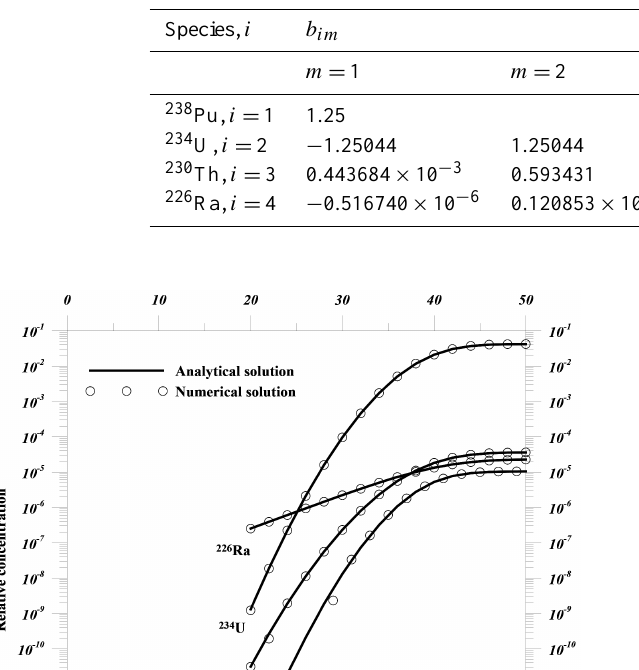
Table 2. Values for coefficients of Bateman-type boundary source for four-species transport problem used by van Genuchten (1985).